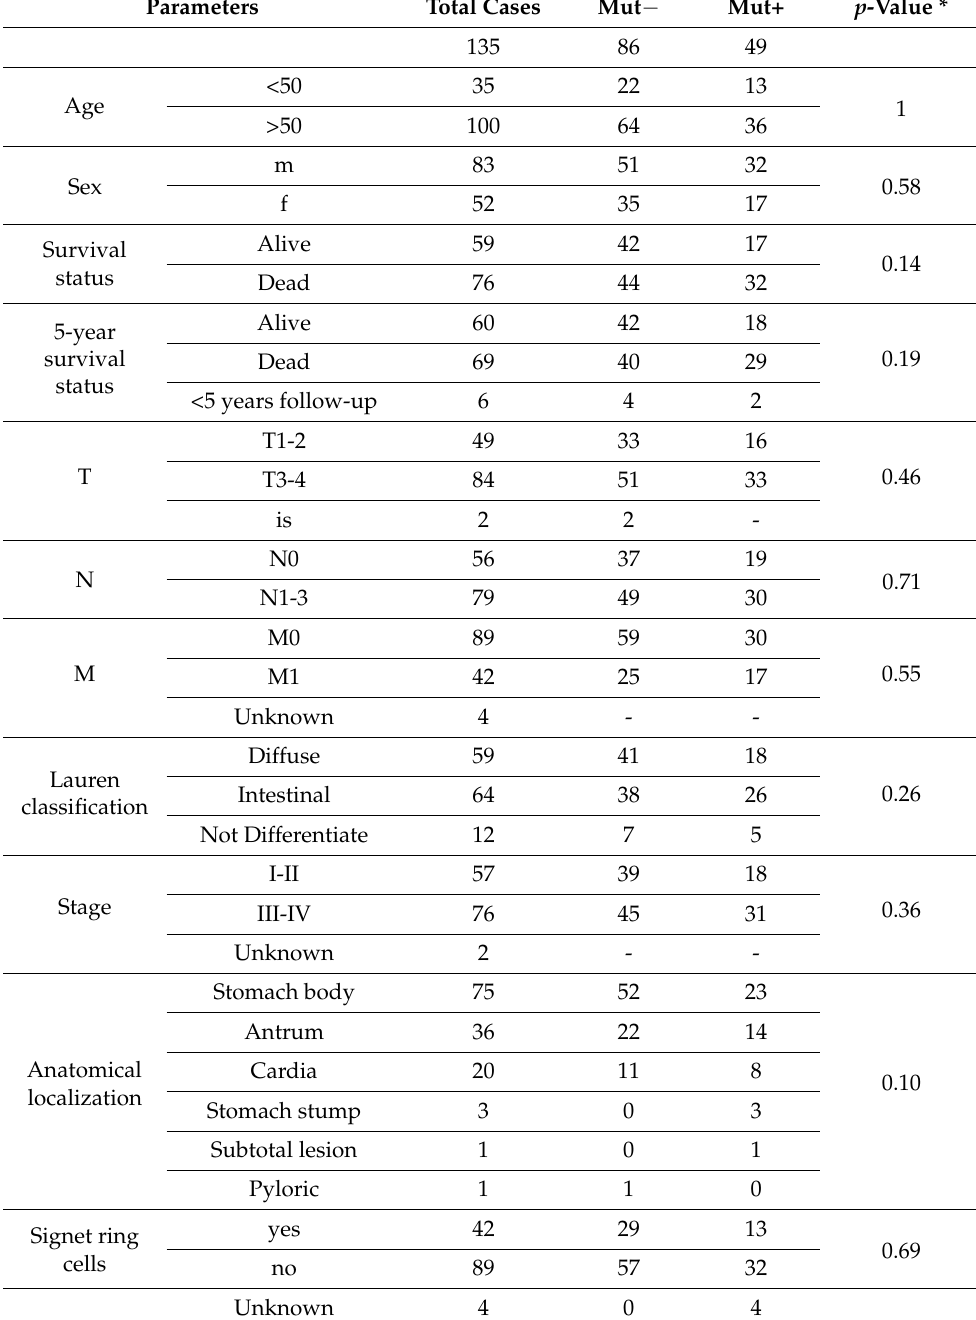
Table 2. Clinical characteristics of patients and their distribution by groups with mutations (mut+) and without mutations (mut − ) in epigenetic regulation genes.